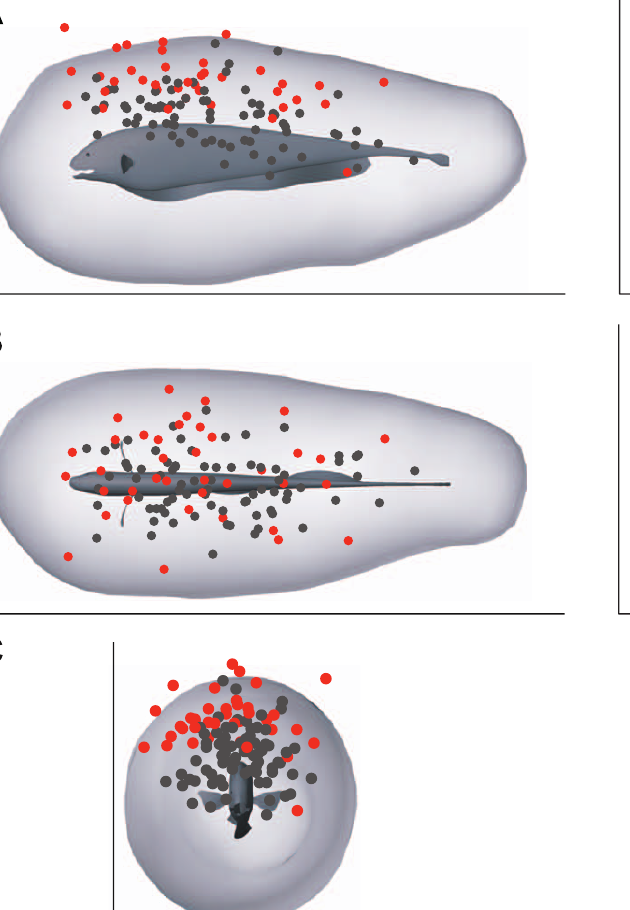
Figure 3. The Computationally Estimated Sensory Volume ( SV ) for Active Electrosensory Detection of D. magna by A. albifrons (A) Side view. (B) Top view. (C) Front view. Body is 14 cm long. Interactive 3-D version is available as Figure S1.